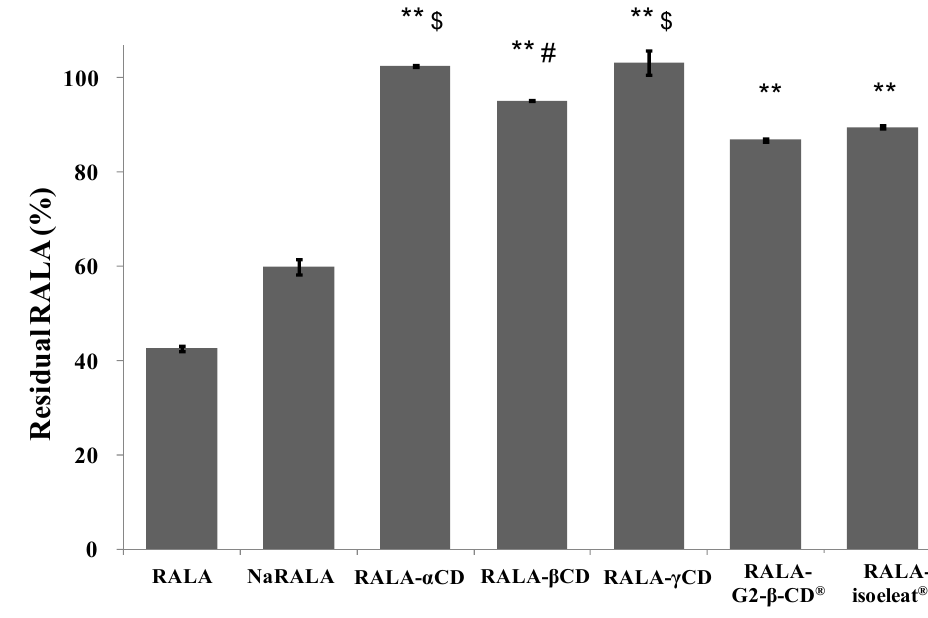
Figure 4. Stability of RALA complexes towards low pH. The samples were incubated at pH 1.2 and 37 °C for 1 h, and the remaining amount of RALA was quantified using HPLC. RALA in the RALA-CD complexes was significantly more stable than free RALA or NaRALA. ** p < 0.01 vs. RALA and NaRALA. $ p < 0.01 vs. RALA- β CD, RALA-G2- β -CD ® and RALA-isoeleat ® P. # p < 0.01 vs. RALA-G2- β -CD ® and RALA-isoeleat ® P. (Fisher’s least significant difference